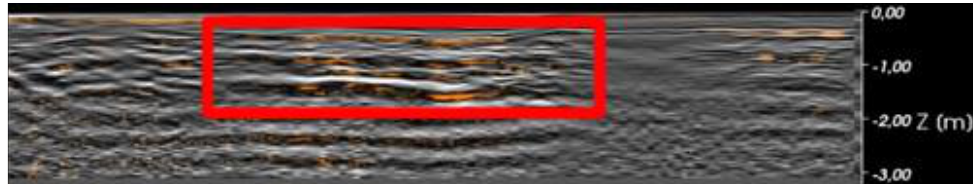
Figure 5. Radargram corresponding to Set 1 (marked in yellow dashed line in Figure 6a).